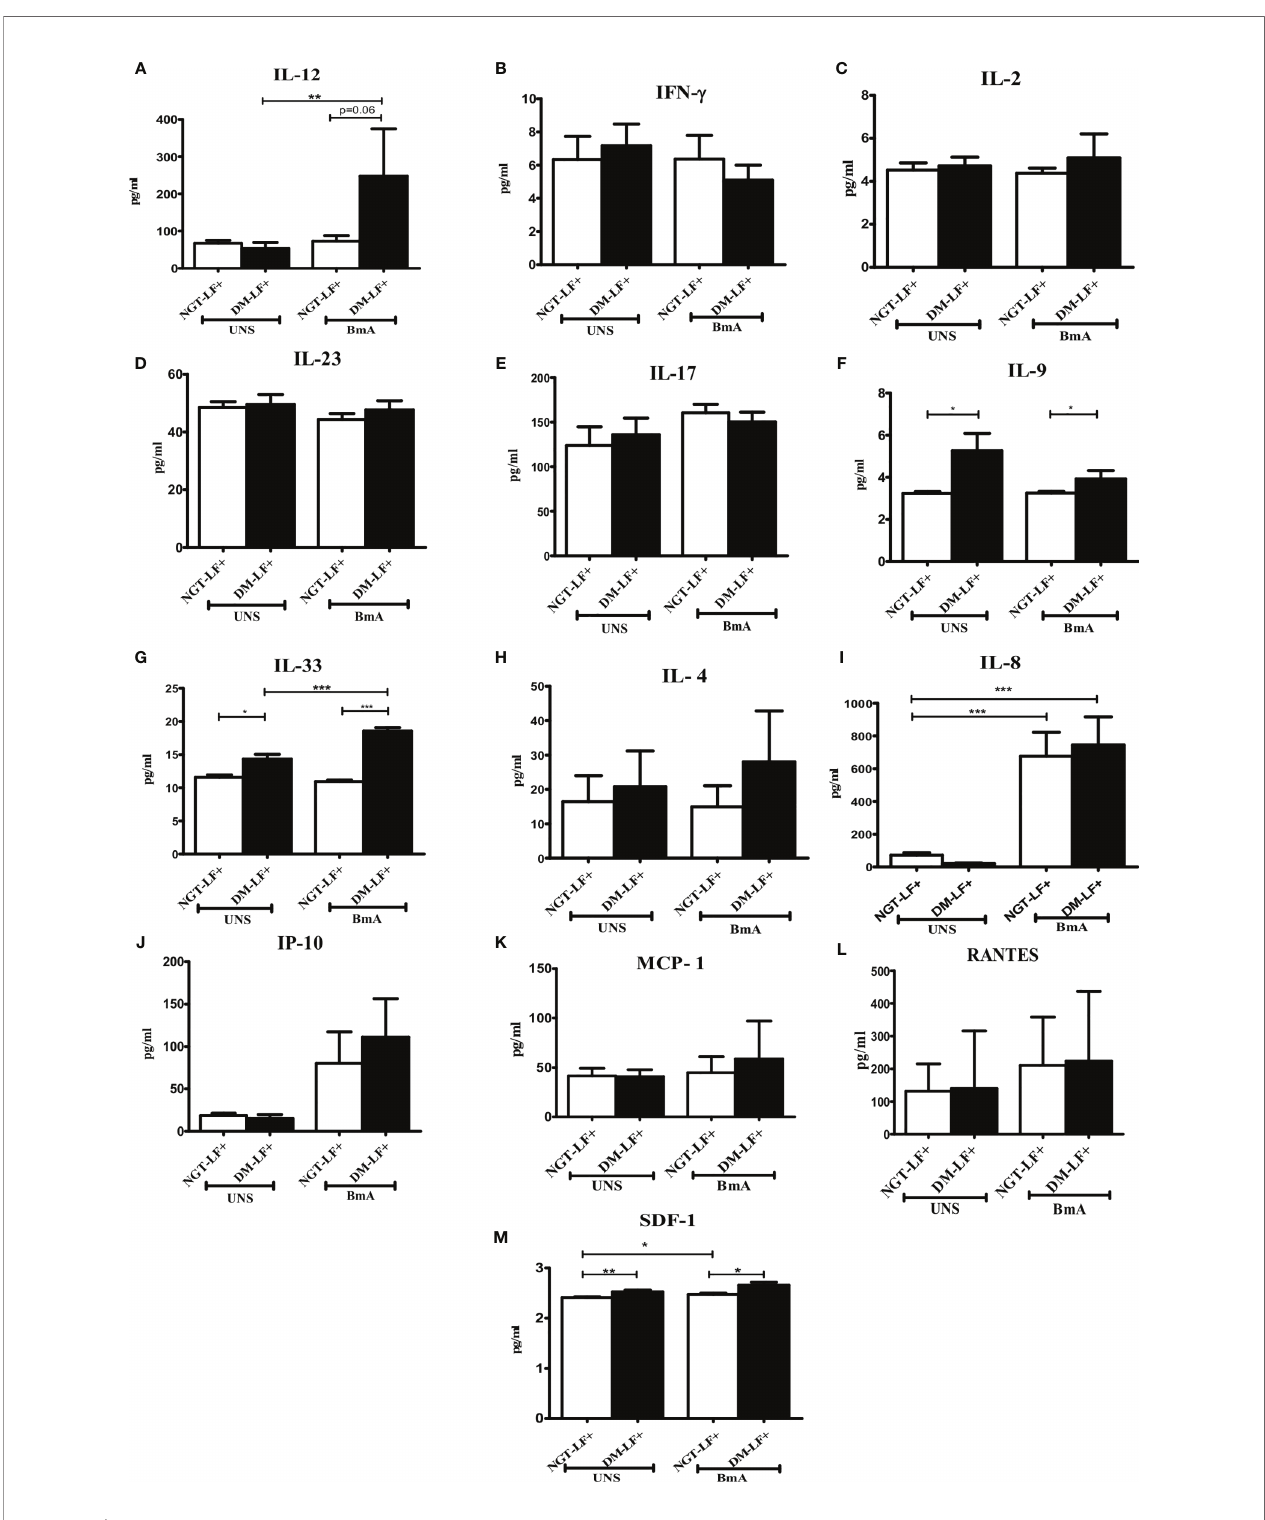
FIGURE 5 | Effect of diabetes on the antigen-induced secretion of adaptive immune cytokines, and chemokines in LF+ subjects. Bar graph showing Unstimulated (UNS) and fi larial antigen (BmA)-induced secretion of IL-12 (A) , IFN- g (B) , IL-2 (C) , IL-23 (D) , IL-17 (E) , IL-9 (F) , IL-33 (G) , IL-4 (H) , IL-8 (I), IP-10 (J) , RANTES (K) , MCP-1 (L) , and SDF-1 (M) in the supernatants of blood cultures in NGT-LF+ and DM-LF+ subjects. Statistical signi fi cance was determined by non-parametric Mann – Whitney U test and p < 0.05 was considered signi fi cant. * p < 0.05; ** p < 0.01; *** p <